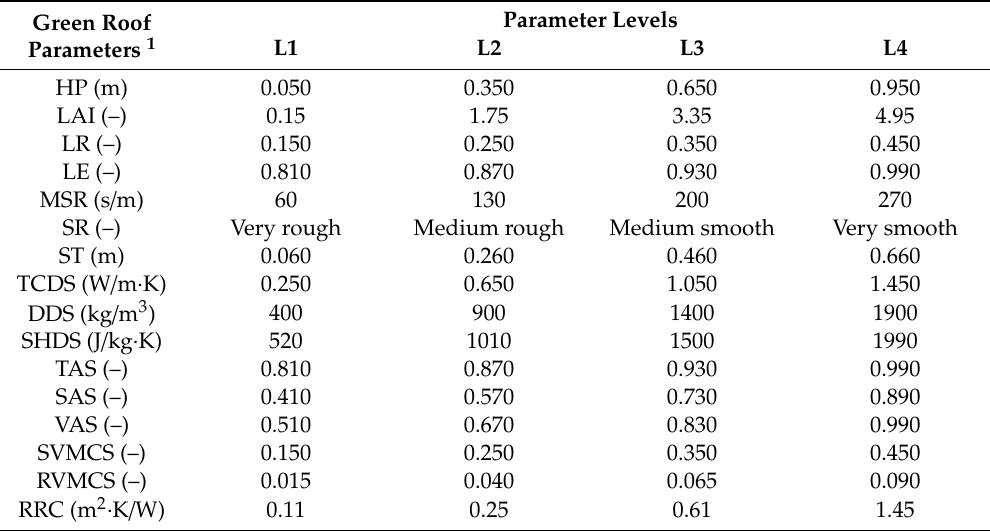
Table 5. Green roof parameters and their levels.